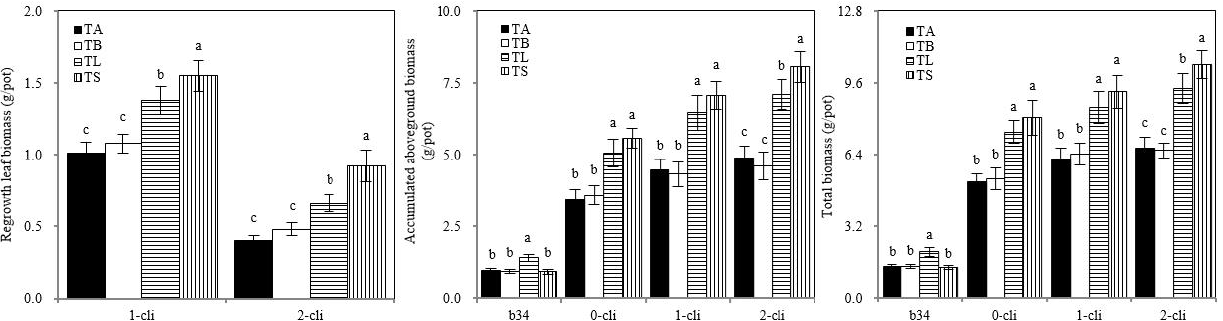
Figure 5. Biomass of Italian ryegrass in the different treatments in the experiment. TA, TB, TS, TL indicate treatments of regrowth with liquid medium without AOB added relatively long before defoliation, regrowth with liquid medium without AOB added shortly before defoliation, regrowth with S2_8_1 strain inoculated relatively long before defoliation, and regrowth with S2_8_1 strain inoculated shortly before defoliation, respectively. “b34”, “0-cli”, “1-cli” and “2-cli” mean, respectively, day 34 before defoliation, days 0, 7 and 14 after defoliation. Biomass refers to dry matter. The values are the mean ± standard error (n = 3). The different letters in each row indicate significant differences ( p < 0.05).